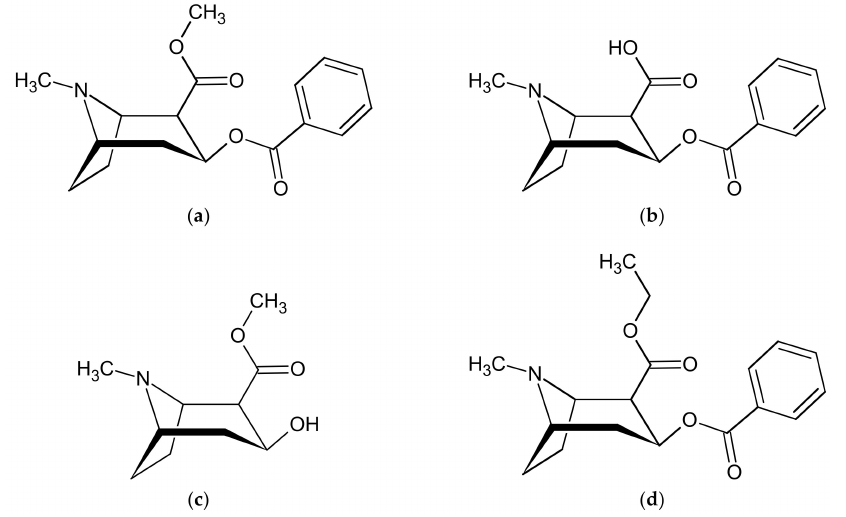
Figure 1. Chemical structures of ( a ) cocaine (COC); ( b ) benzoylecgonine (BEG); ( c ) ecgonine methyl ester (EME); ( d ) cocaethylene